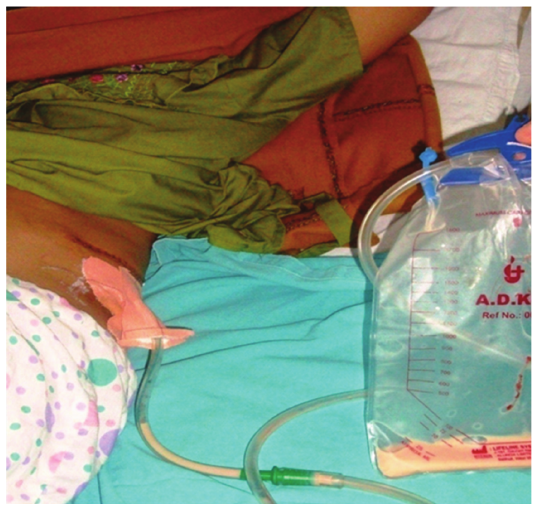
Figure 3: Case number 2 with retroperitoneal drain in